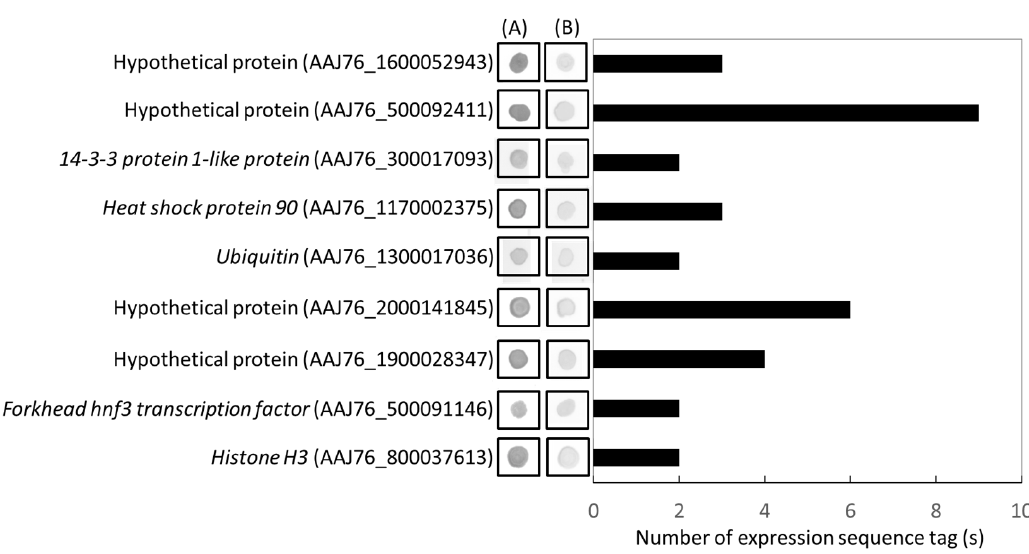
Figure 4. Distribution of expression sequence tags (ESTs) belong to eighteen N. ceranae specific genes and dot-blot hybridization test the cDNA library of N. ceranae -infected cDNA library. ( A ) The probes that came from subtractive PCR products of the N. ceranae -infected cDNA library was used to test the cDNA library of N. ceranae -infected cDNA library; ( B ) the probes that came from unsubtractive PCR products of the control honey bee cDNA library was used to test the cDNA library of the N. ceranae -infected cDNA library.